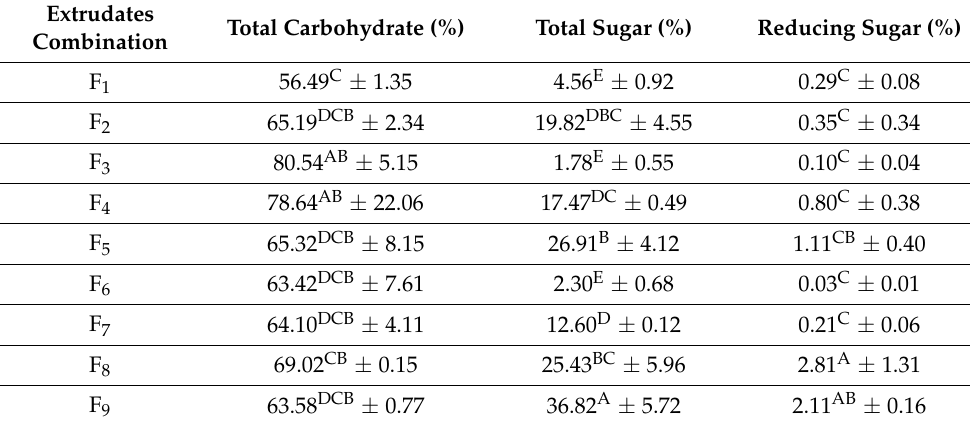
Table 8. Biochemical properties of neera honey incorporated